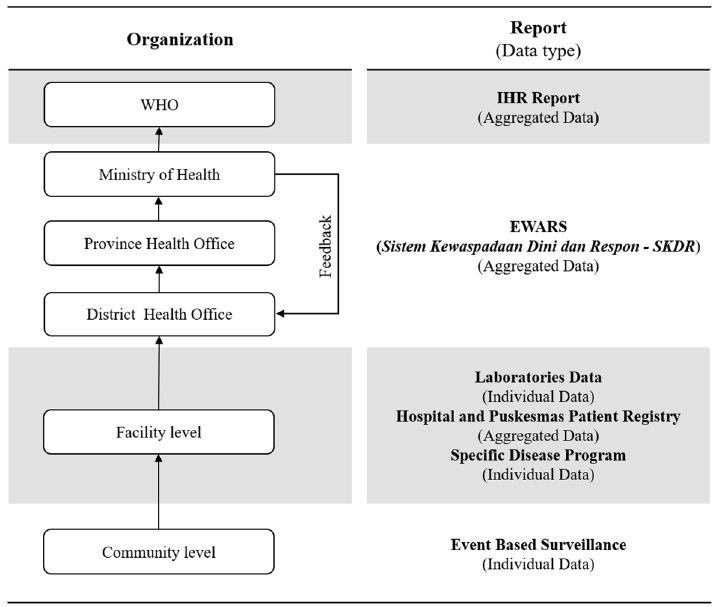
Figure 1. Flow chart of data report and management in the Indonesian Early Warning Alert and System (EWARS).